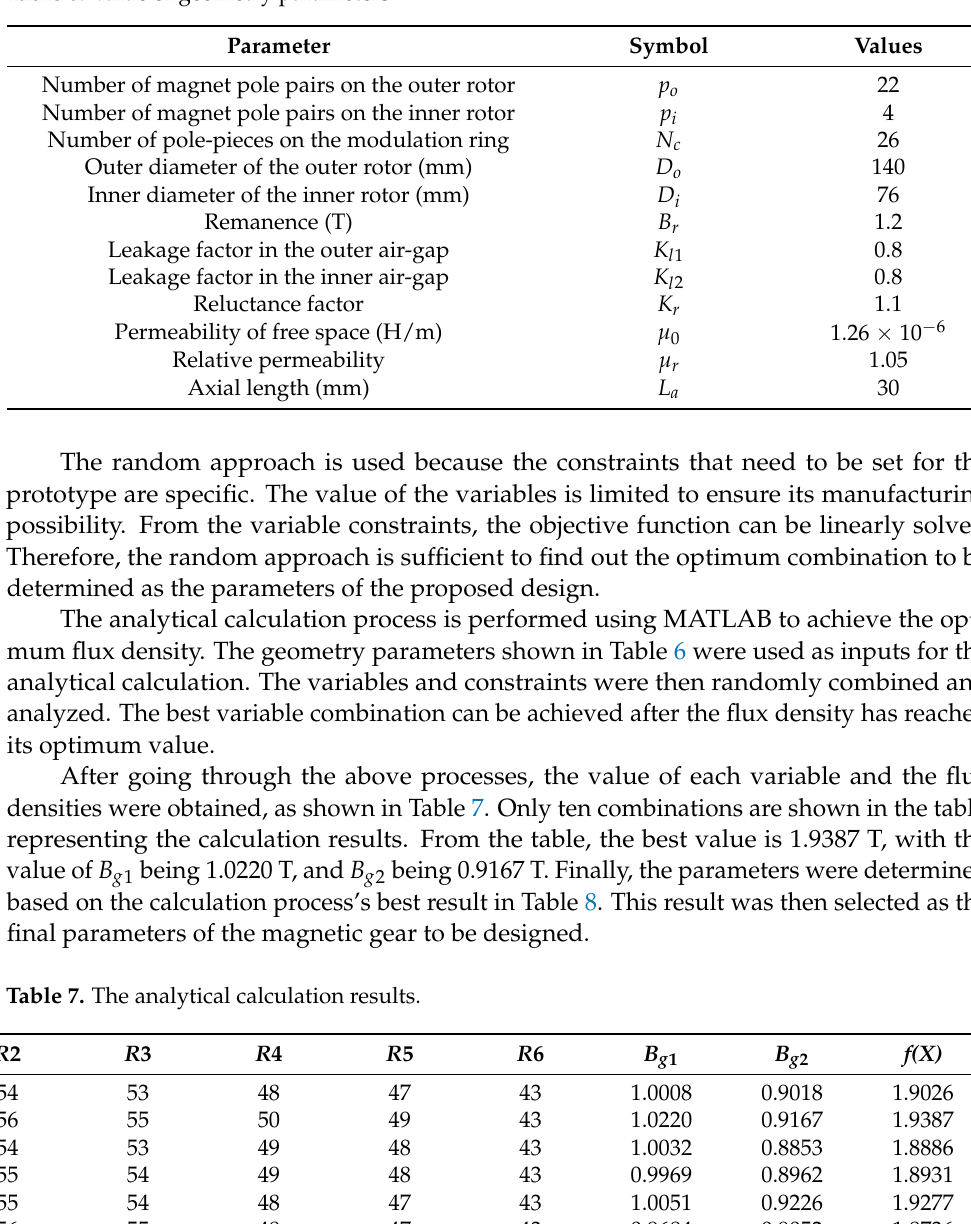
Table 6. Value of geometry parameters.